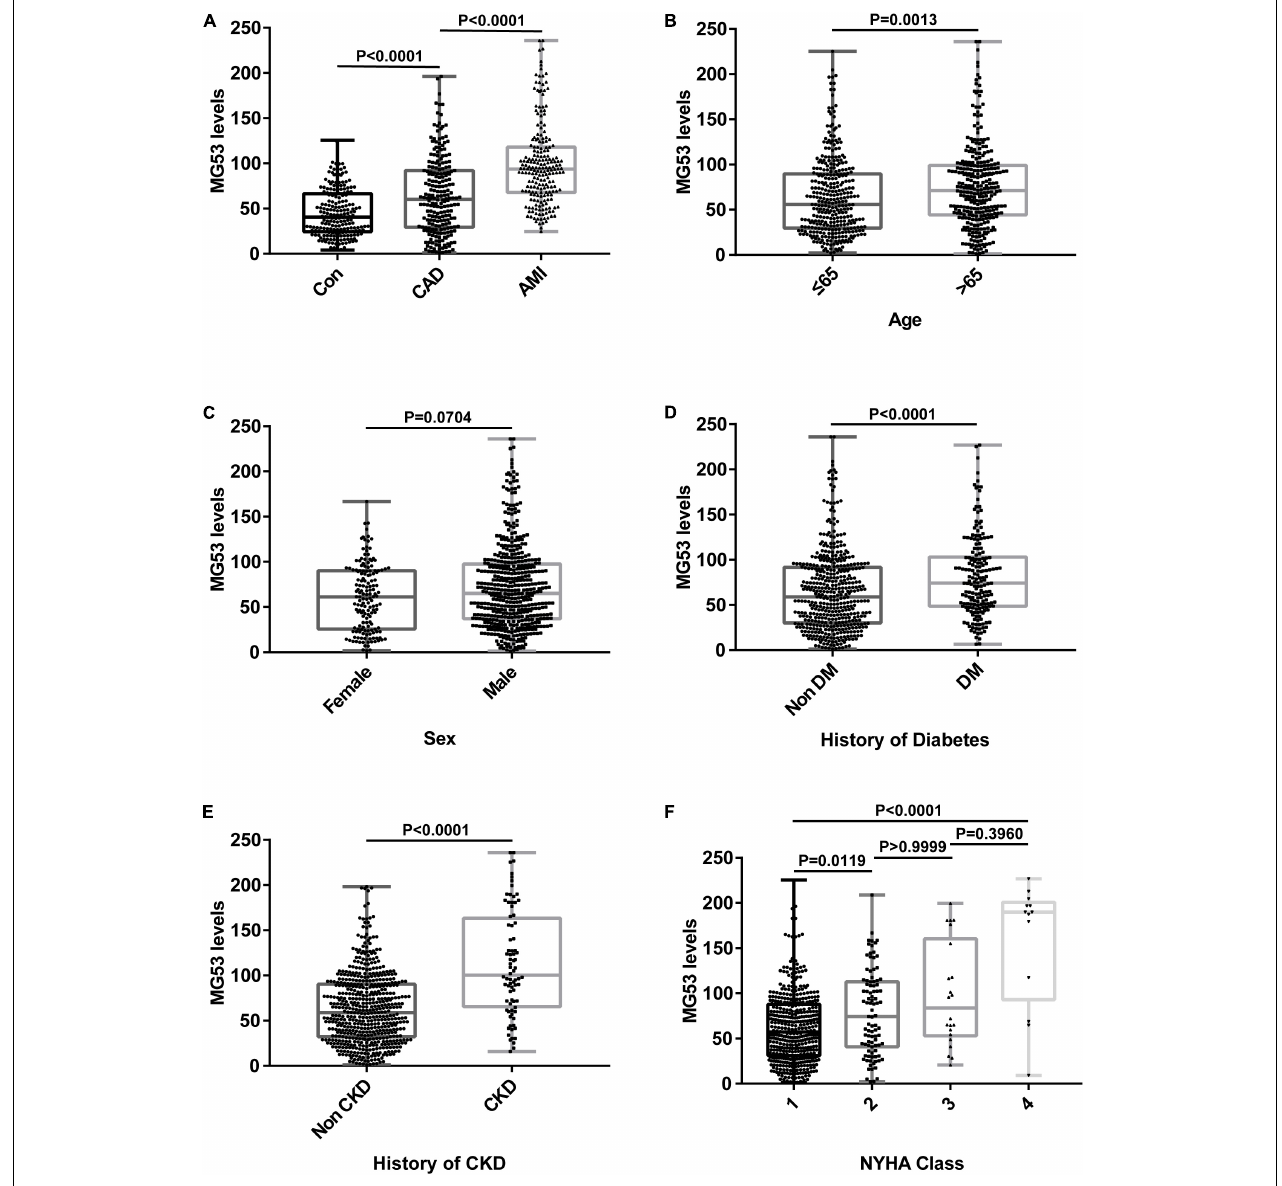
FIGURE 1 | Concentration of serum MG53 in different groups. (A) Comparison of serum MG53 levels in patients with CAD, AMI, or negative coronary angiography. (B) Stratified analyses were performed by age ( ≤ 65 years/ > 65 years). (C) Stratified analyses were performed by gender (men/women). (D) Comparison of serum MG53 levels in patients with or without diabetes. (E) Comparison of serum MG53 levels in patients with or without CKD. (F) Serum mg53 levels were highest in patients with the 4th New York Heart Association (NYHA) functional